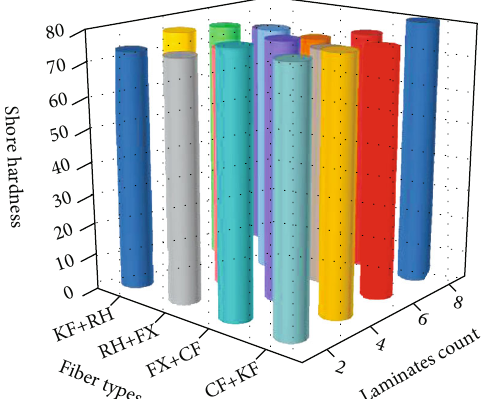
Figure 14: Shore hardness: 3D plot of fi ber types and laminate